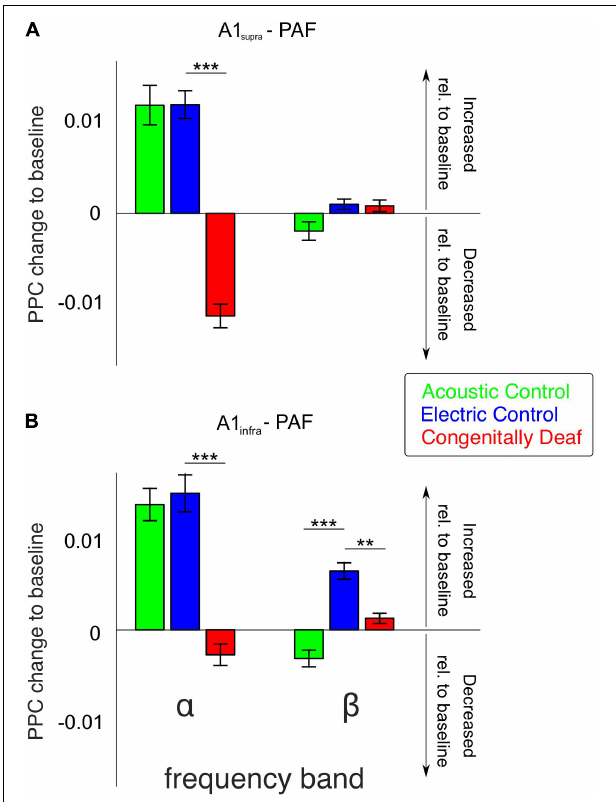
FIGURE 5 | Bar plots of average alpha- and beta-band functional connectivity within the late poststimulus time window for all three groups, separately for A1 supra – PAF (A) and A1 infra – PAF (B) couplings. Data shown correspond to the change in PPC relative to baseline (baseline PPC subtracted from poststimulus PPC). Positive (negative) values indicate increased (decreased) functional connectivity relative to pre-stimulus baseline, respectively. Group pairwise comparisons were computed using the two-tailed Wilcoxon rank-sum test. ** P < 0.01; *** P < 0.001.